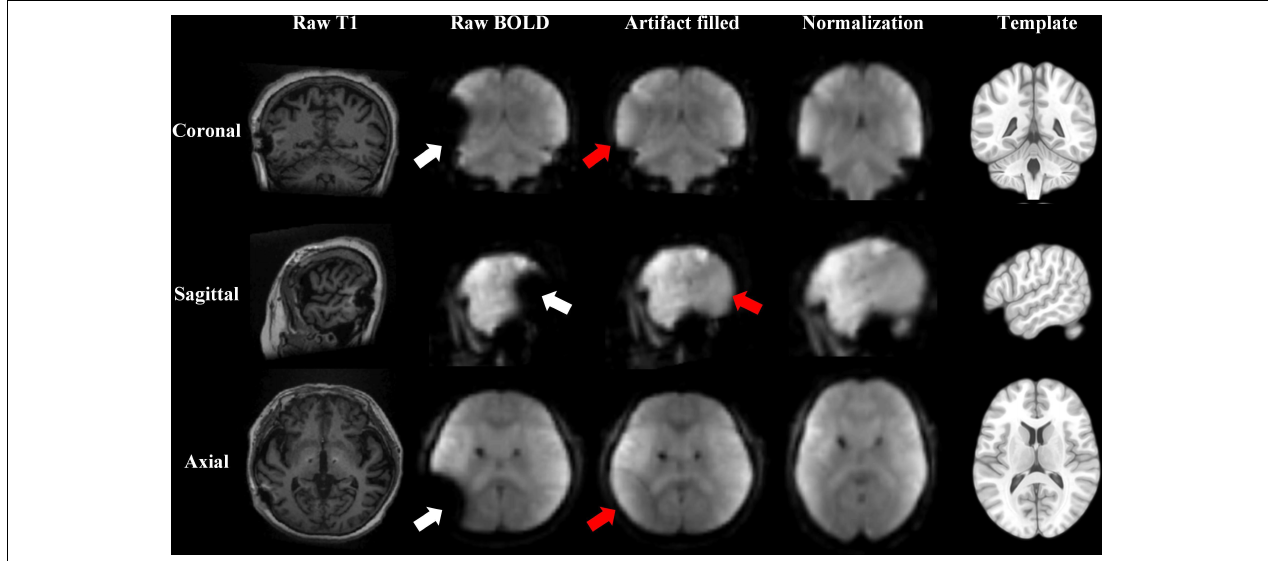
FIGURE 1 | Resting-state fMRI data preprocessed after the deep brain stimulation (DBS) artifact was filled. An enantiomorphic normalization method was used to fill the artifacts of the raw blood-oxygen-level-dependent (BOLD) data, to improve the accuracy of normalization to the Montreal Neurological Institute (MNI) space. The white arrow shows the artifact lesion. The red arrow shows the filled lesion. The results are displayed from coronal, sagittal, and axial views in three rows. The columns show the raw T1 image, raw BOLD image, and BOLD image after the artifacts were filled; the BOLD image after normalization; and the MNI template from left to